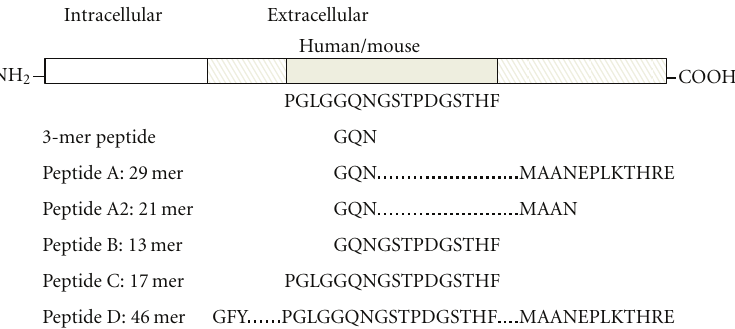
Figure 1: Structure of TCTA and sequences of peptides. Structure of TCTA showing both intra-cellular (white bar) and extra-cellular (meshed bar) domains. Black bar shows the human/mouse identical sequence in the extra-cellular domain.